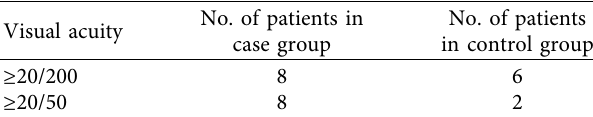
Table 3: Comparison of visual outcomes of EE patients with and without